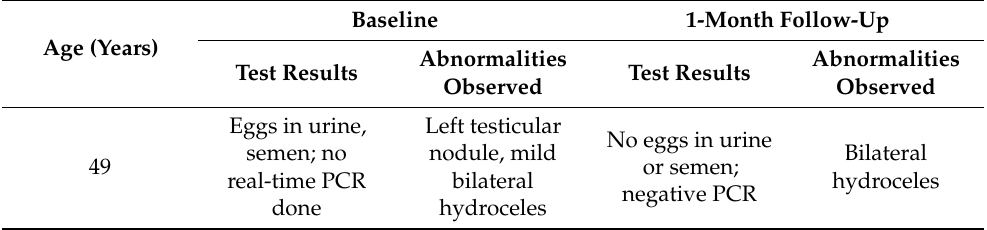
Table 4. Observations on ultrasonography of one participant at baseline and one-month follow-up.